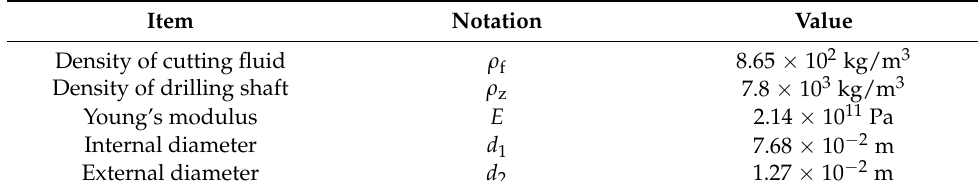
21Figure.5a Chaotic motion ω = 8 Figure.5b Periodic motion ω = Figure.5c Quasi-periodic ω = 29.9 Figure.5d Chaotic motion ω = 35 Figure.5e Periodic Motion ω = 46.35 Figure.5f Periodic Motion ω = 47.5 Figure.5g Chaotic motion ω = 59.5 Figure.5h Quasi-periodic ω = 89.5 Figure.5i Chaotic motion ω = 110 Figure.5j Periodic Motion ω = 119 Figure.7a Chaotic motion μ = 0.426 Figure.7b Quasi-periodic μ = 0.571 Figure.7c Periodic Motion μ = Figure.9a Periodic Motion β = 0.218 Figure.9b Quasi-periodic β = 0.521 Figure.9c Chaotic motion β = 0.752 Figure.11a Quasi-periodic u 0 = 3.384 Figure.11b Periodic Motion u 0 = 4.018 Figure.11c Chaotic motion u 0 = 4.386